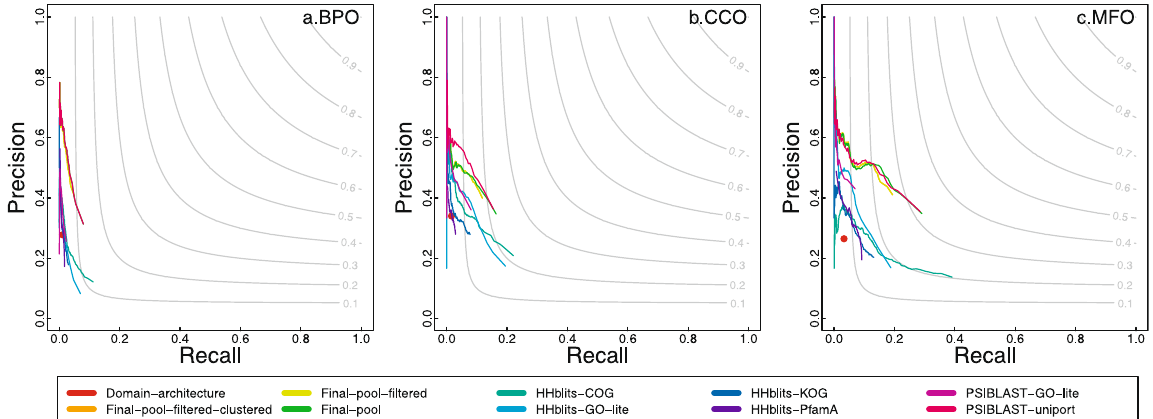
Figure 1. The precision-recall plot of PANDA and other predictors. The predicted and real GO terms are not propagated to the root in the GO directed acyclic graph; and two GO terms are considered a match only if they are the same. The “Final-pool” is based on predictions pooled from all predictors before filtered by Z-score. The “Final-pool-filtered” is before applying GO term clustering using affinity propagation but after filtered by GO term Z-score. The “Final-pool-filtered-clustered” is after the clustering and second round of filtering that is based on clustering results. “Domain-architecture” is a red dot in the plot because we assign a constant confidence score to all predictions from it (see Methods for details).